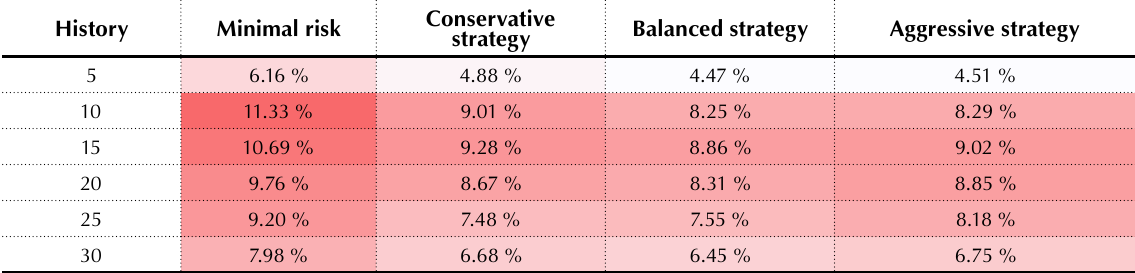
Table 5. Riskiness of individual portfolios measured by the variation coefficient History Minimal